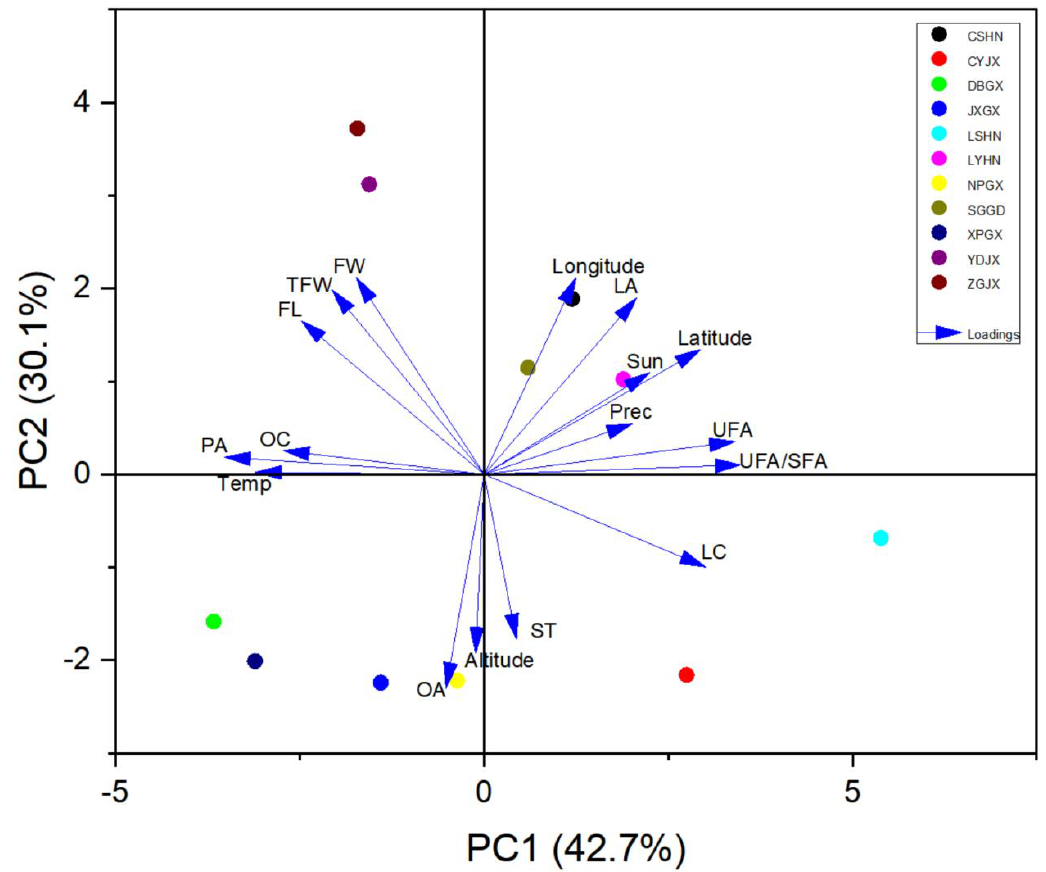
Figure 3. The relationship between 11 populations of S. wilsoniana based on PC1 and PC2. Abbreviations: Temp., average monthly temperature; Sun. Dur., average annual sunshine duration; Prec., average annual precipitation; FL, fruit length; FW, fruit width; TFW, thousand fruit weight; OC, oil content; PA, palmitic acid; SA, stearic acid; OA, oleic acid; LA, linoleic acid; LC, linolenic acid; UFA, unsaturated fatty acid; SFA, saturated fatty acid.